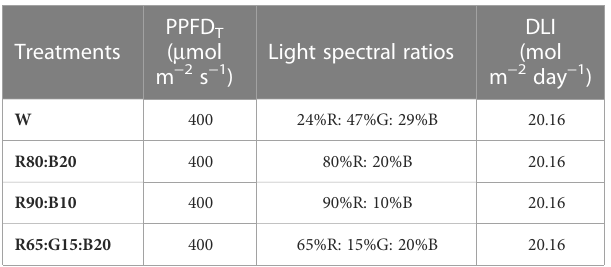
TABLE 2 Properties of the treatments applied in experiment 2.